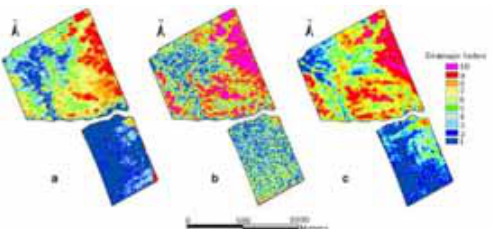
Fig. 10: Within-field soil drainage mapping using canonical variates derived from a) hyperspectral reflectance principal components (HR PCs ), b) C-Band SAR linear HH and VV polarizations, and c) apparent soil electrical conductivity within 0–30 cm (ECa30) and 0–100 cm (ECa100) depths. A higher drainage index represents a better drainage condition.